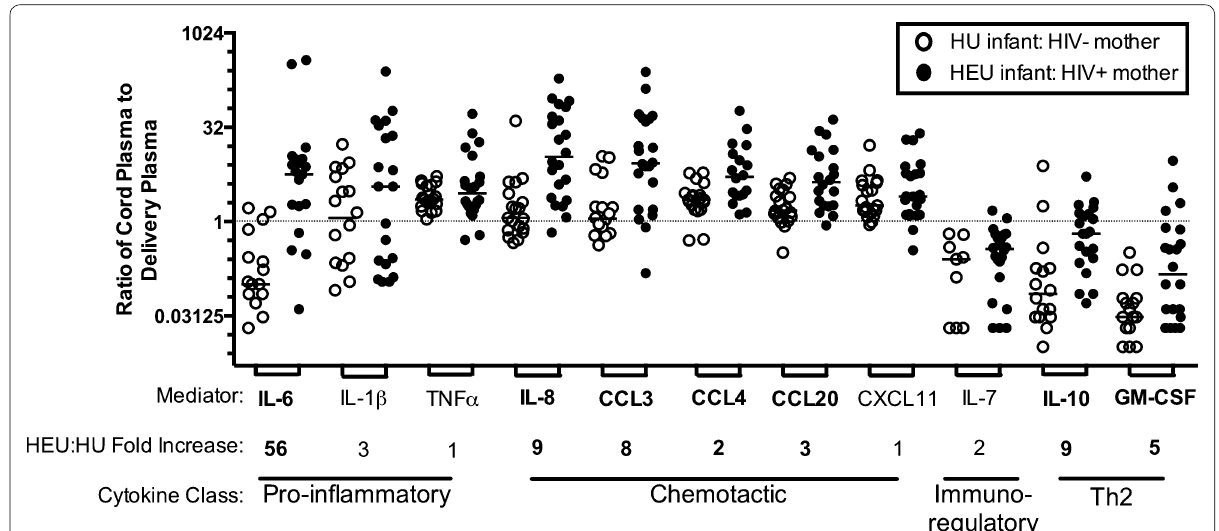
Fig. 2 HIV infection associated with changes in delivery and birth cytokine patterns. Cytokines were detected in samples from all maternal delivery plasma and infant cord blood plasma using multiplexed Luminex Elisa bead‑based technology and grouped by broad category. Assays at or below the lower limit of detection were assigned the lowest limit of detection. Cytokines undetectable in the majority of HEU or HU samples were not included: IL‑5, IL‑21, IL‑23 and CX3CL1. The ratio of infant cord blood to maternal delivery blood plasma cytokine levels was calculated. Each cytokine ratio is plotted for HU infant‑HIV negative mother (open circles) and HEU infant‑HIV‑infected mother (closed circles) and the fold change from the HU group median is indicated. Independent group medians were compared using Mann–Whitney U test with correction for multiple comparisons p < 0.005. Significant mediators are bolded